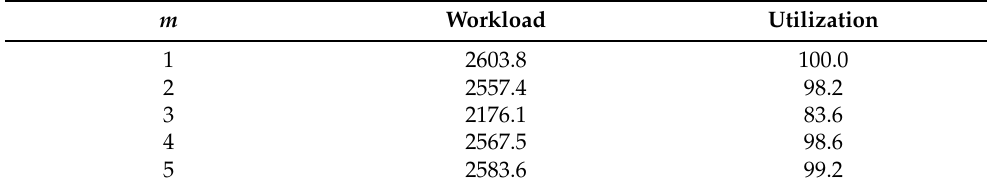
Table 8. Machine workload related performance (ˆ l max and ˆ l max − ˆ l min